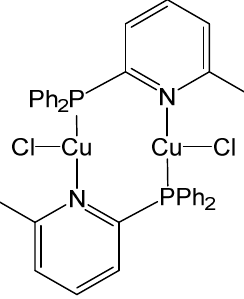
∩ N) 2 Cl 2 (P 2 featuring both TADF and phosphorescence